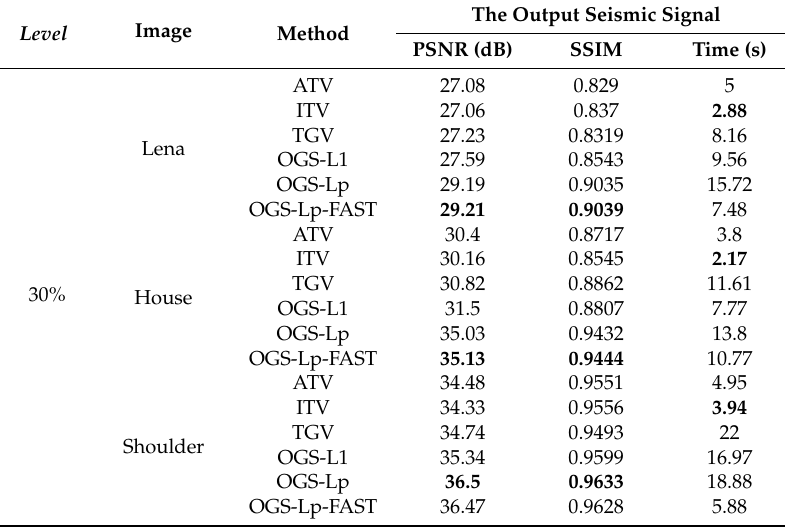
Table 3. Numerical comparison of our proposed method and other models (images are corrupted by impulse noise of